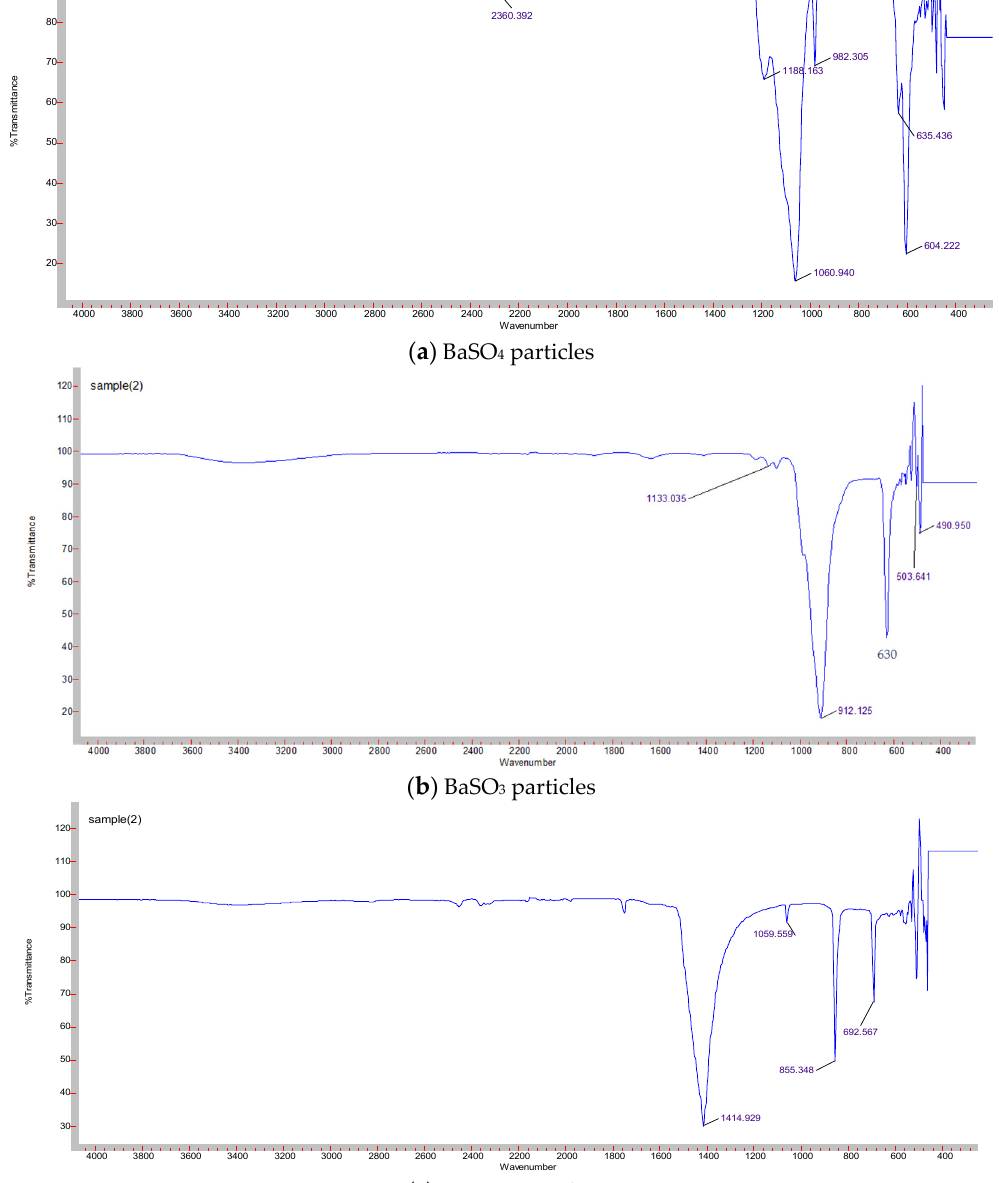
Figure 3. FT-IR analysis of Ba salt particles. ( a ) Shows characteristic peaks for BaSO 4 particles. Characteristic peaks are detected at 2360 cm − 1 , 1188 cm − 1 , 1060 cm − 1 , 982 cm − 1 , 1635 cm − 1 , 604 cm − 1 , and 637 cm − 1 . ( b ) Represents characteristic peaks for BaSO 3 particles at 490 cm − 1 , 630 cm − 1 , 912 cm − 1 , and 1133 cm − 1 . ( c ) Represents characteristic peaks for BaCO 3 particles at 855 cm − 1 , 692 cm − 1 , 1414 cm − 1 , and 1059 cm − 1 .